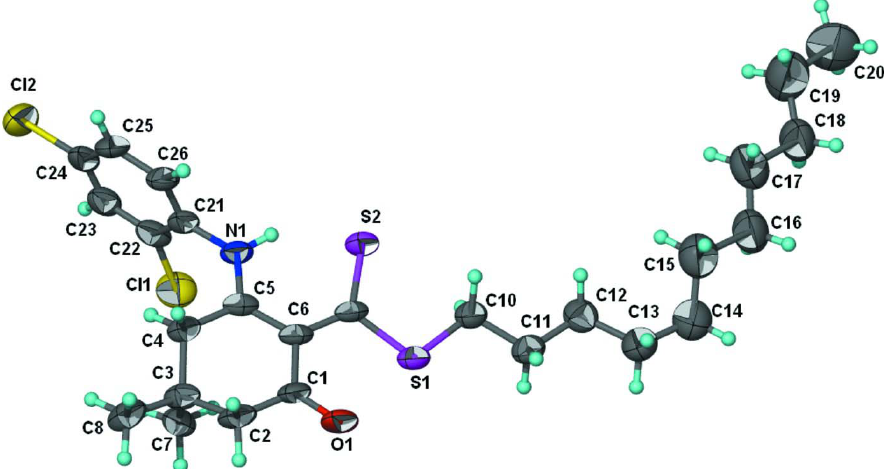
Figure 1 Anisotropic displacement ellipsoid plot (Barbour, 2001) plot of C atoms are drawn as spheres of arbitrary